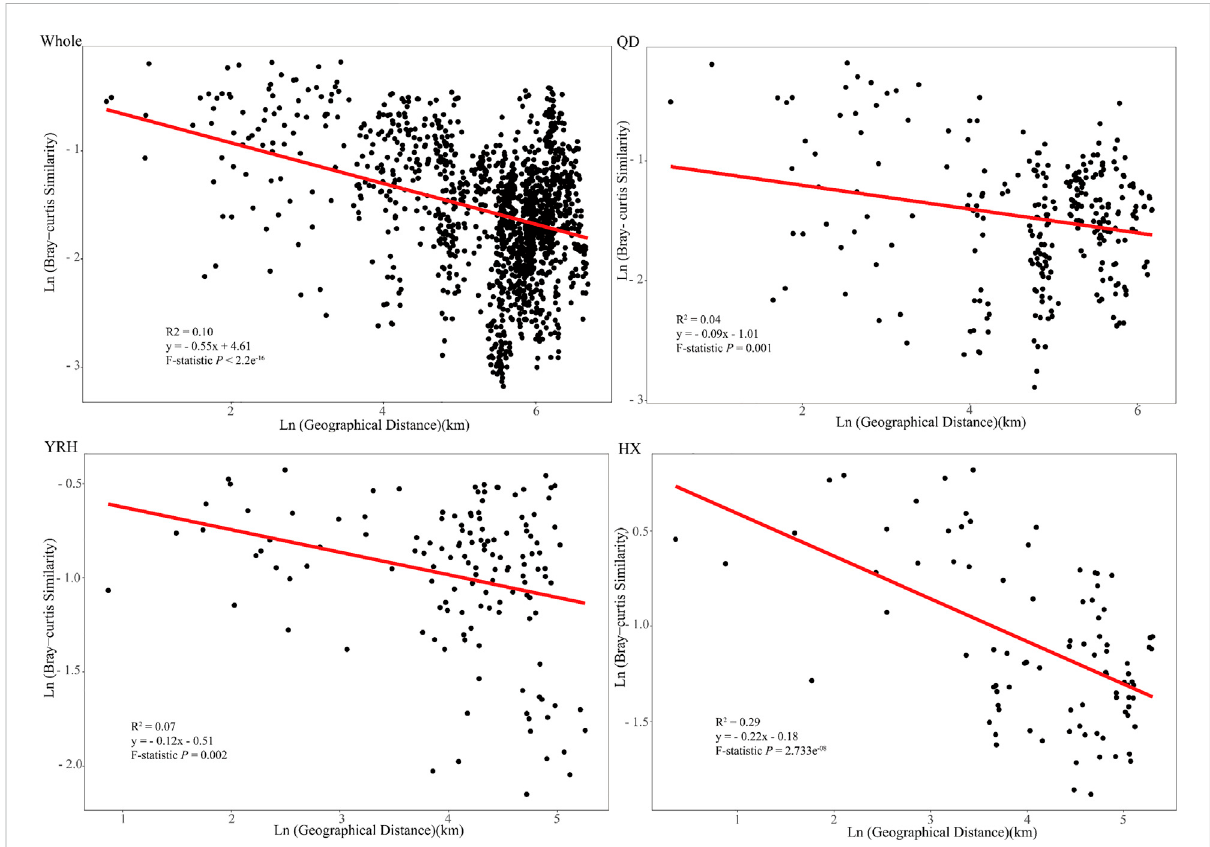
FIGURE 6 Therelationshipbetweenbacterialcommunitysimilarity(Bray-Curtis) andgeographicdistance (Euclideandistance)betweenanytwosampling sites in each